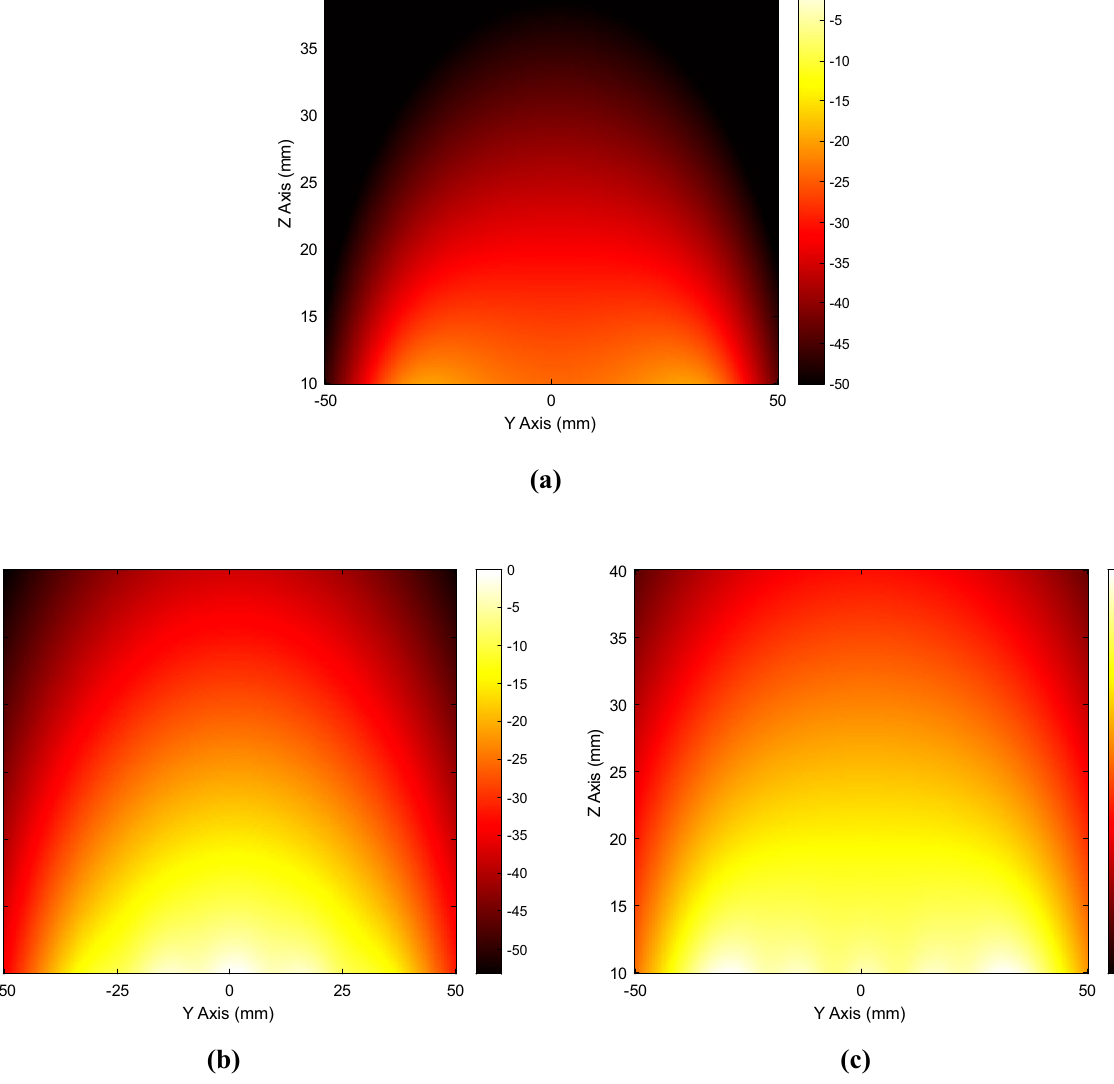
Figure 7. Normalized magnetic field map (normalized to their own maximum values and expressed in dB)) evaluated on a plane perpendicular to the metasurface ( yz plane in Fig. 3a): fed driving coil without ( a ) and with standard ( b ) and homogenized ( c ) metasurface. To ensure a fair comparison, the same circulating current is forced into the driving coil. As evident, both the metasurfaces are able to enhance the H-field amplitude. However, the unit-cells currents uniformity results in a significantly more homogeneous magnetic field